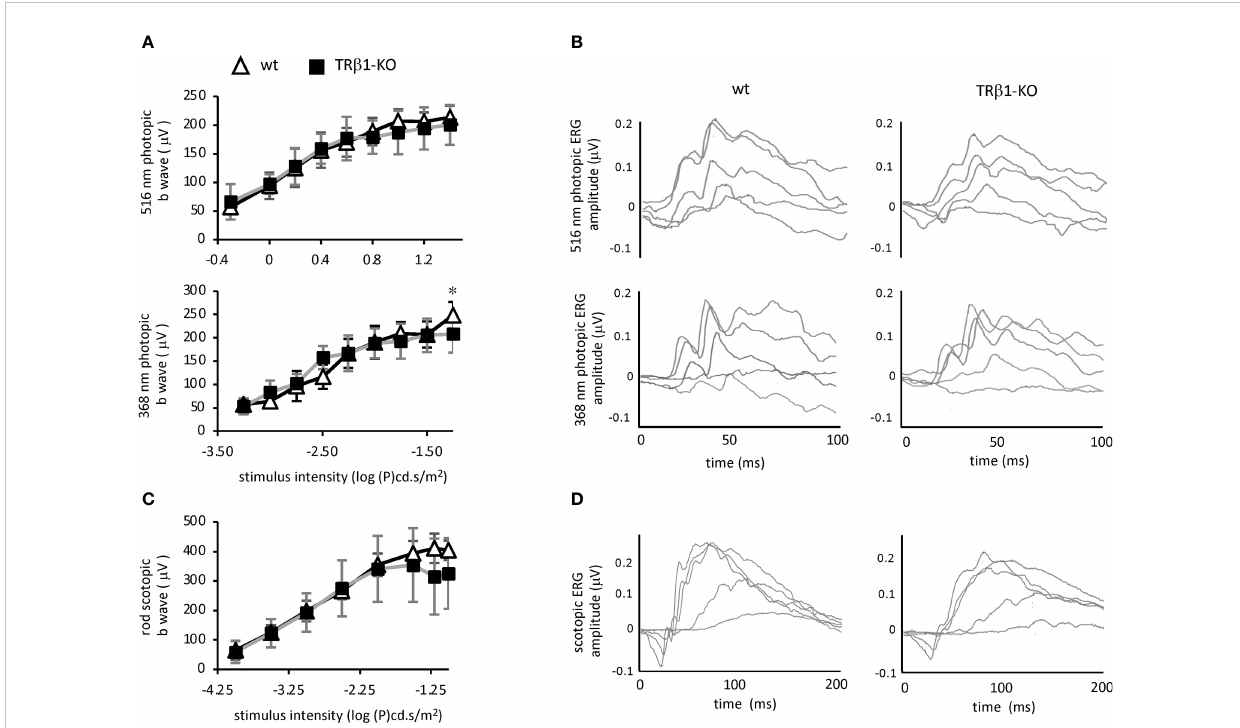
FIGURE 7 Electroretinogram analysis of TR b 1-KO mice. (A) , Photopic, light-adapted responses to optimal wavelengths for stimulation of cone M opsin (516 nm) and S opsin (368 nm) in mice. Curve plots show b-wave magnitudes, mean ± S.D. Groups, 6 wild type and 8 TR b 1 KO mice, ~2 months of age. * p < 0.05, unpaired t-test for each stimulus intensity. (B) , Example waveforms in response to varying stimulus intensities in single representative mice; intensities of 1.26, 3.16, 10, 19.95 and 32 cd.s/m 2 for 516 nm; 0.0001, 0.001, 0.0031, 0.01 and 0.0316 cd.s/m 2 for 368 nm. (C) , Scotopic, dark- adapted responses indicating rod function, showing b wave magnitudes, mean ± S.D. Groups, 8 wt and 7 TR b 1 KO mice, 6 - 8 weeks old. (D) , Example waveforms for varying stimulus intensities of 0.0001, 0.001, 0.01, 0.0316 and 0.1 cd.s/m 2 for scotopic